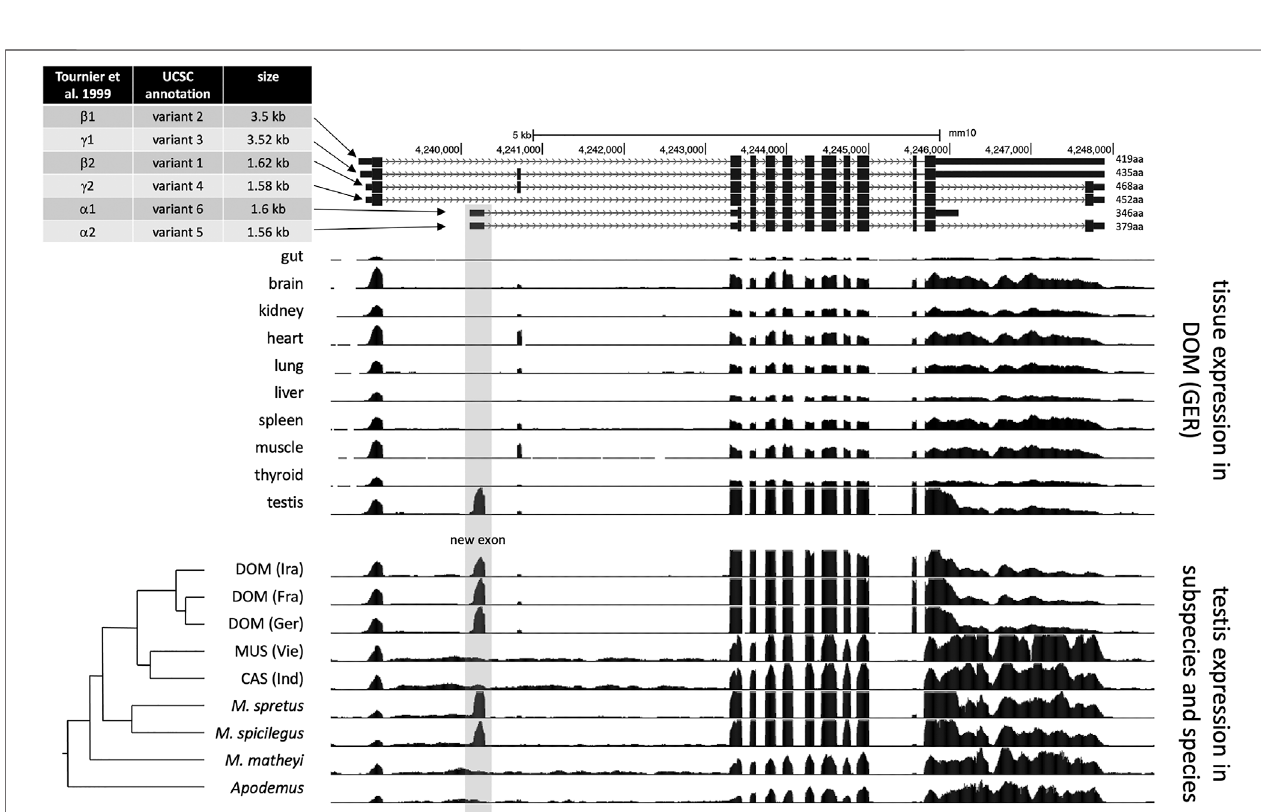
FIGURE 2 | Map2k7 transcript variants and transcriptome read coverage. The fi gure is based on UCSC genome browser (Kent et al., 2002) tracks for the mouse GRCm38/mm10 reference sequence (Waterston et al., 2002). The top panel shows the different transcript and splice versions from the mouse reference genome, representing M. m. domesticus and therefore includes the new promoter/exon (highlighted by grey shading). The middle panel is based on data from (Harr et al., 2016) and shows transcriptome read mapping tracks for different tissues. The lower panel is based on transcriptome data from (Harr et al., 2016) and (Neme and Tautz, 2016)andshowstranscriptomereadmappingtracksfordifferentpopulations,subspecies,andspecies.Thephylogeneticrelationshipsaredepictedtotheleft.DOM: M. m. domestics , MUS: M. m. musculus , CAS: M. m. castaneus .